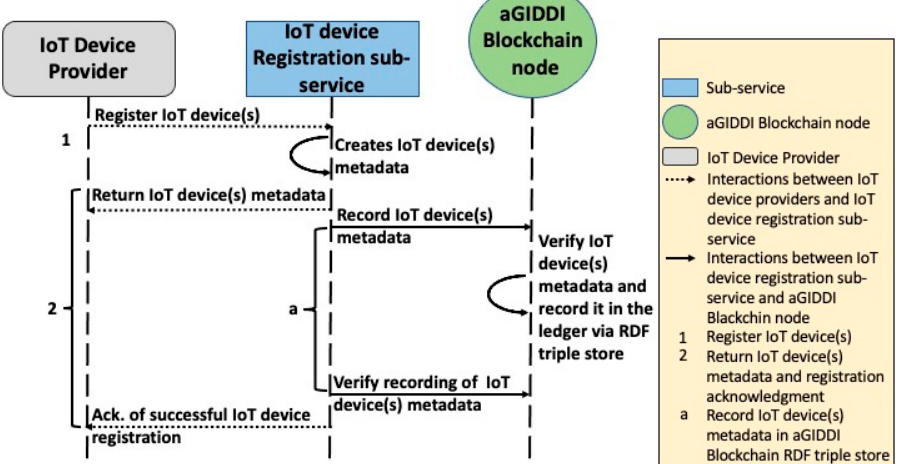
Figure 7. aGIDDI protocol for IoT device registration.